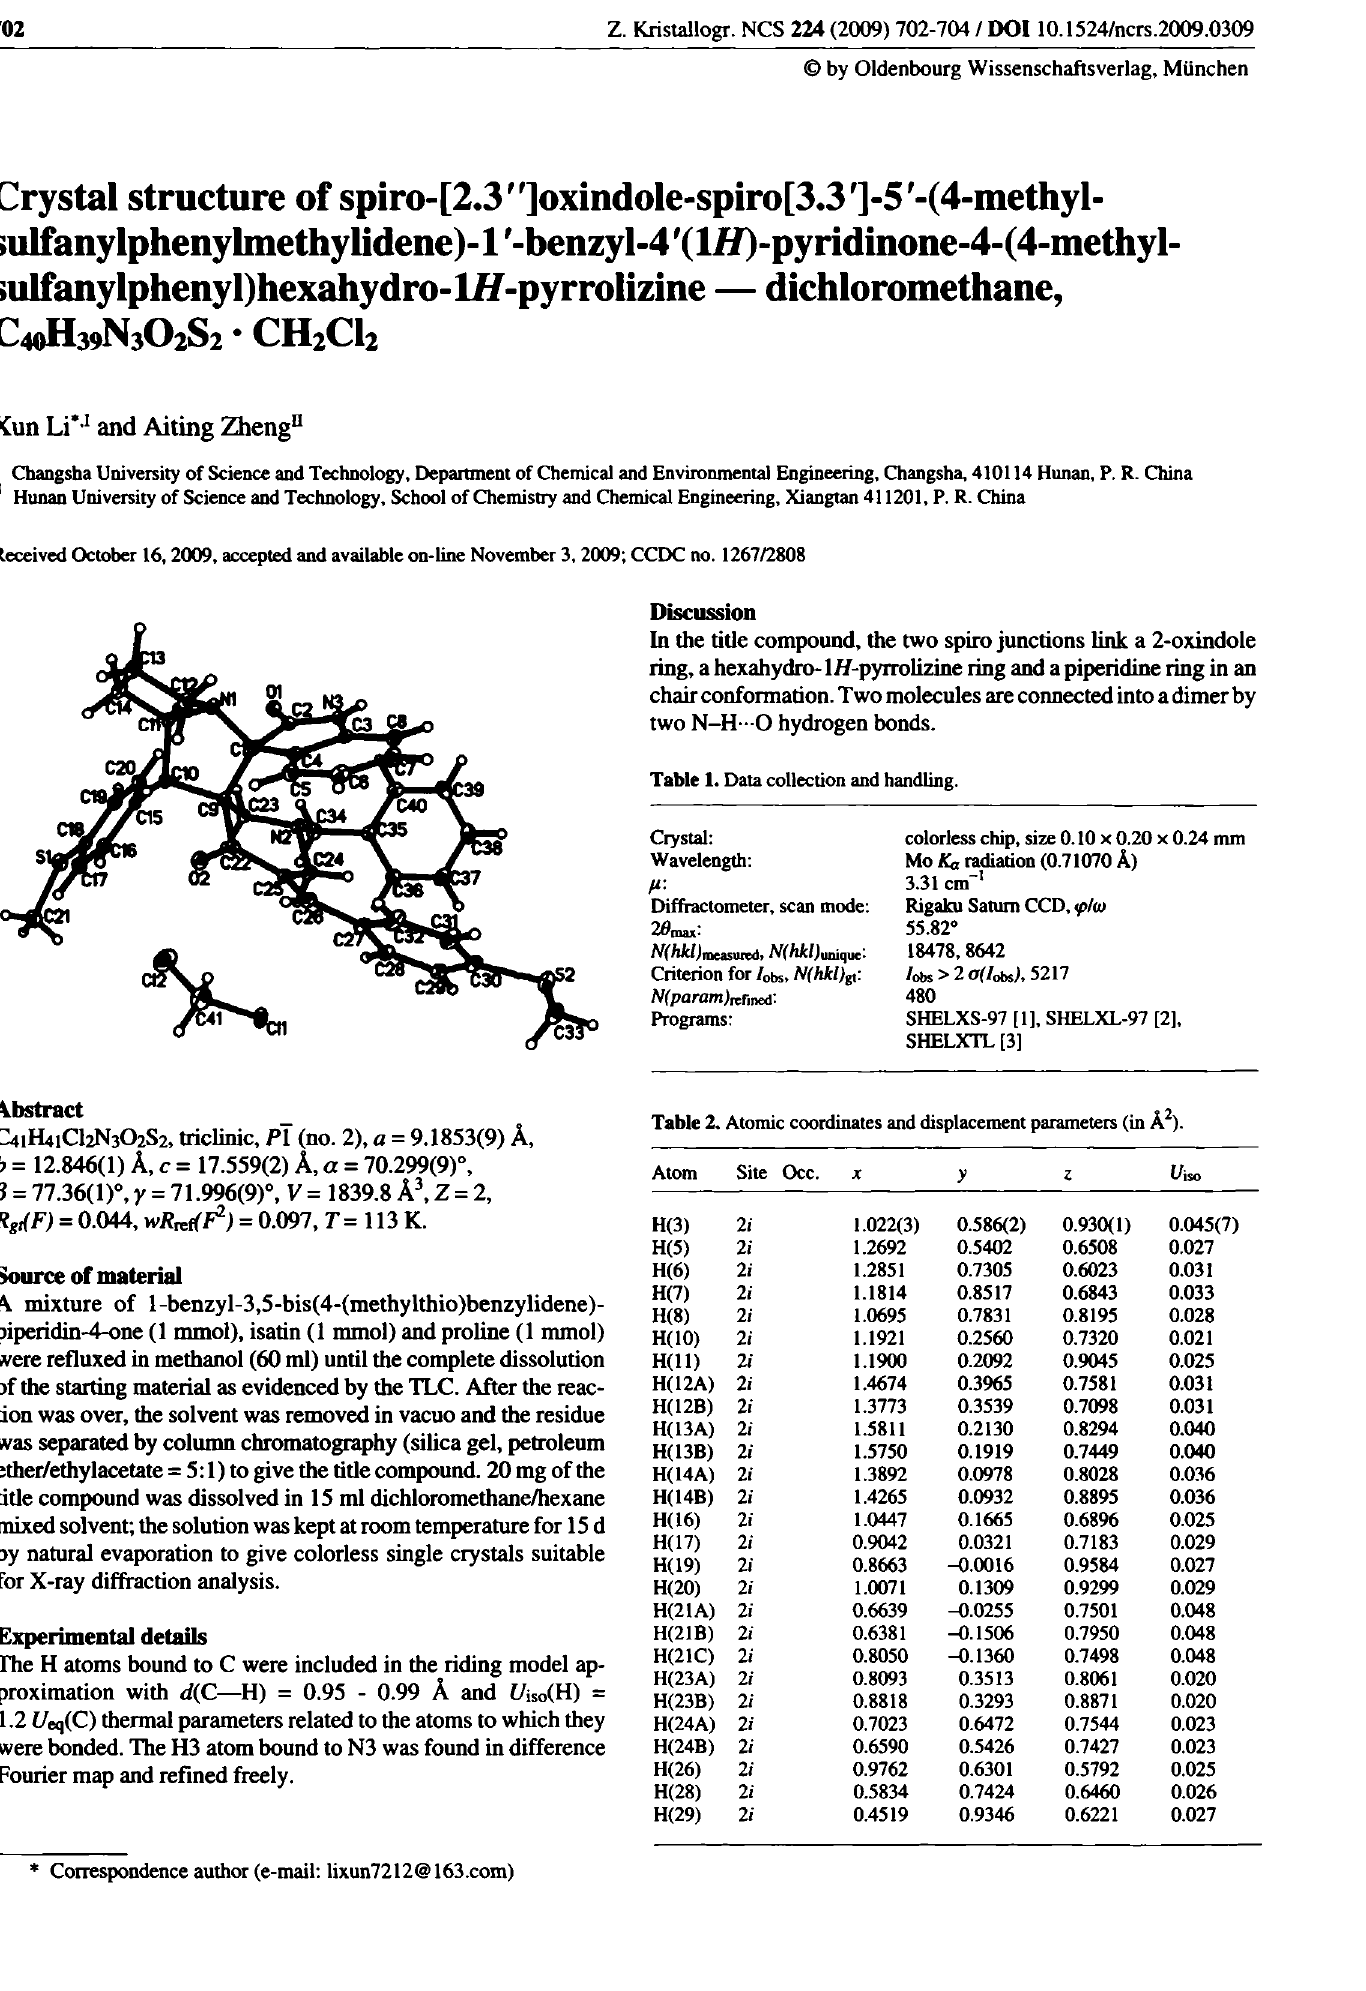
Table 2. Atomic coordinates and displacement parameters (in Â 2